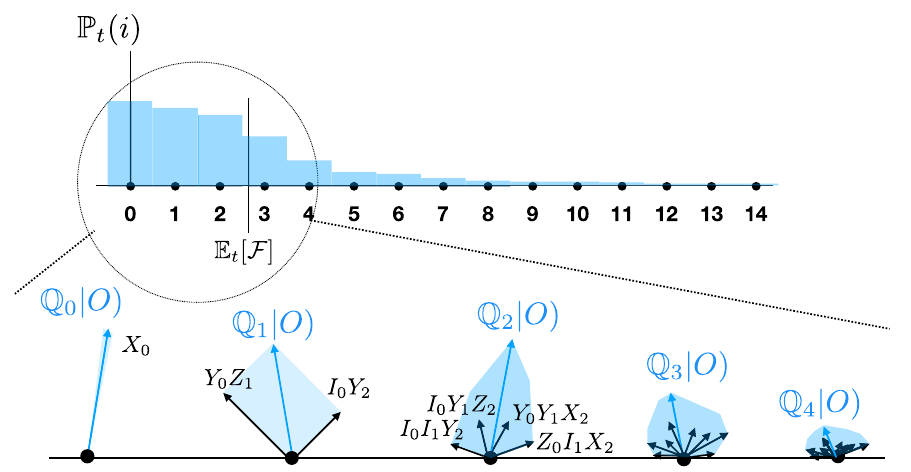
FIG. 5. The 4 L -dimensional space of operators can be decomposed into the direct sum of L subspaces f Q rightmost occupied site. By keeping track of only the “ average value ” of the rightmost site (depicted above), keeping in mind that an exponential number of orthogonal operators (depicted below) are contained on most of the sites, we reduce the quantum walk of many- body operators from an exponentially large space to a one-dimensional